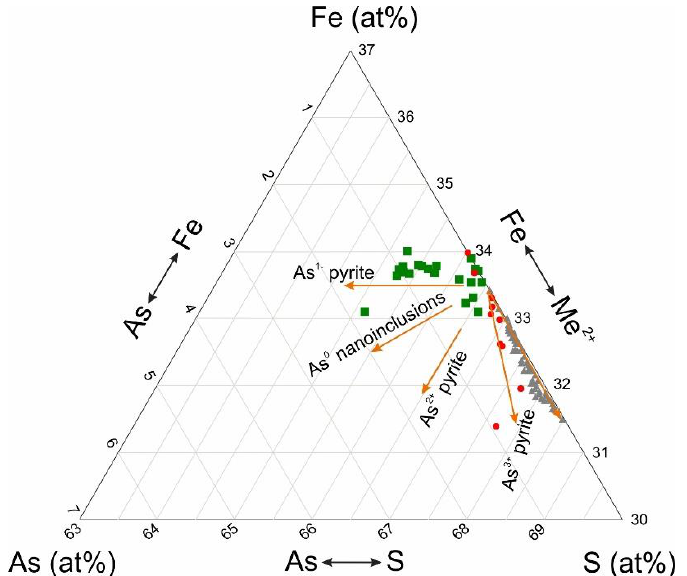
Figure 12. Ternary diagram of As‐S‐Fe in pyrite from Paleochori Bay (adopted from Deditius et al. [91] and Román et al. [109]). The different trends show substitution of (1) As for S (colloform As 1− pyrite I; ML38A), (2) As 3+ for Fe (massive As 3+ pyrite II, ML22B); and (3) substitution of divalent metals (Me 2+ ) for Fe (massive pyrite II, ML11A).